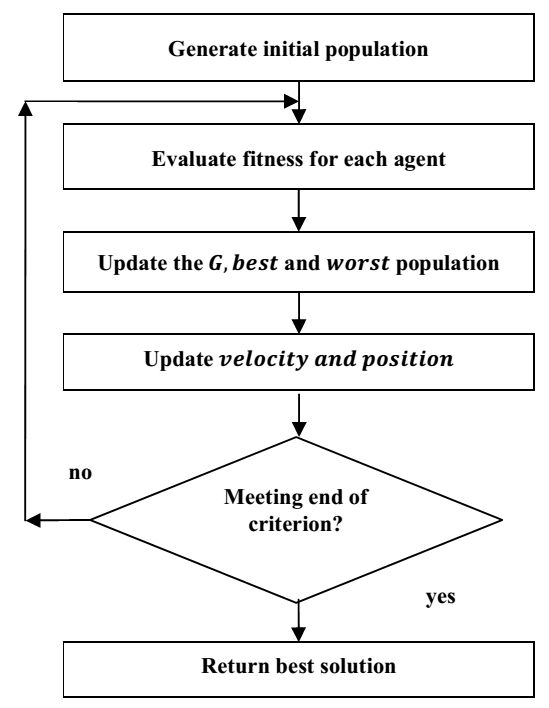
Figure 1: General principle of GSA